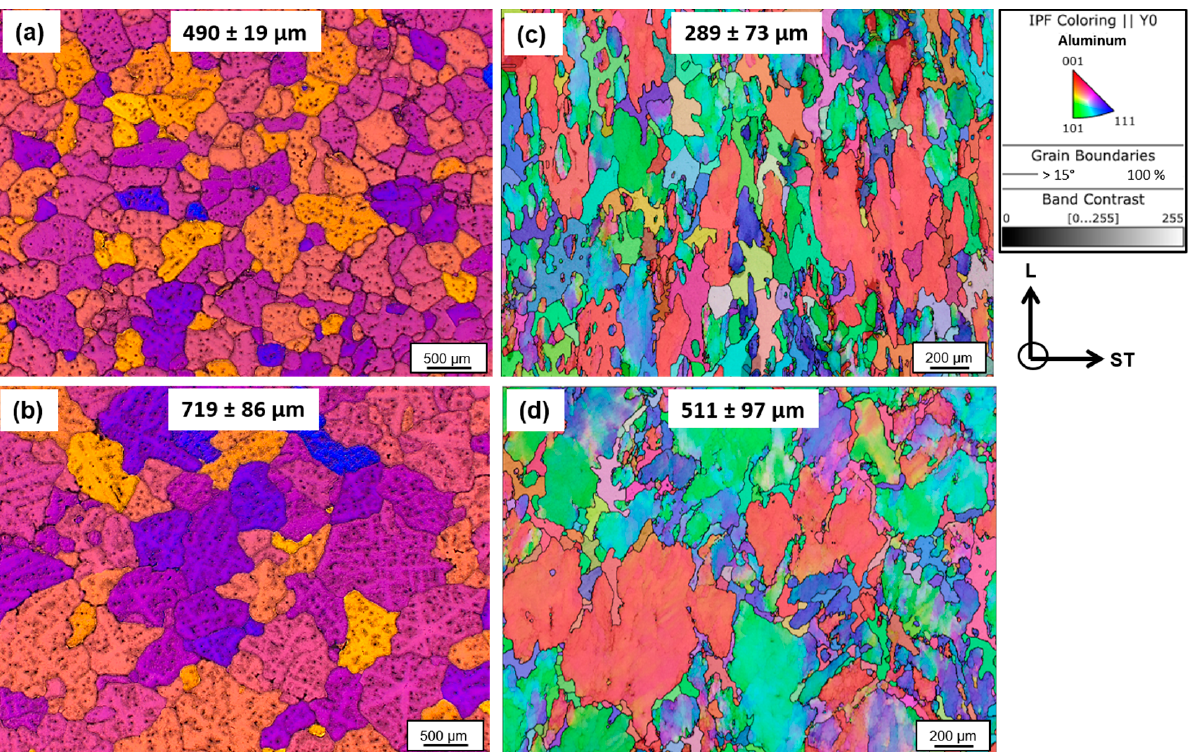
Figure 3. Barker-etched images of grains in as-cast condition: ( a ) 7449; ( b ) 7449+Cr and EBSD IPF maps after processing to T4 state; ( c ) 7449; ( d ) 7449+Cr.